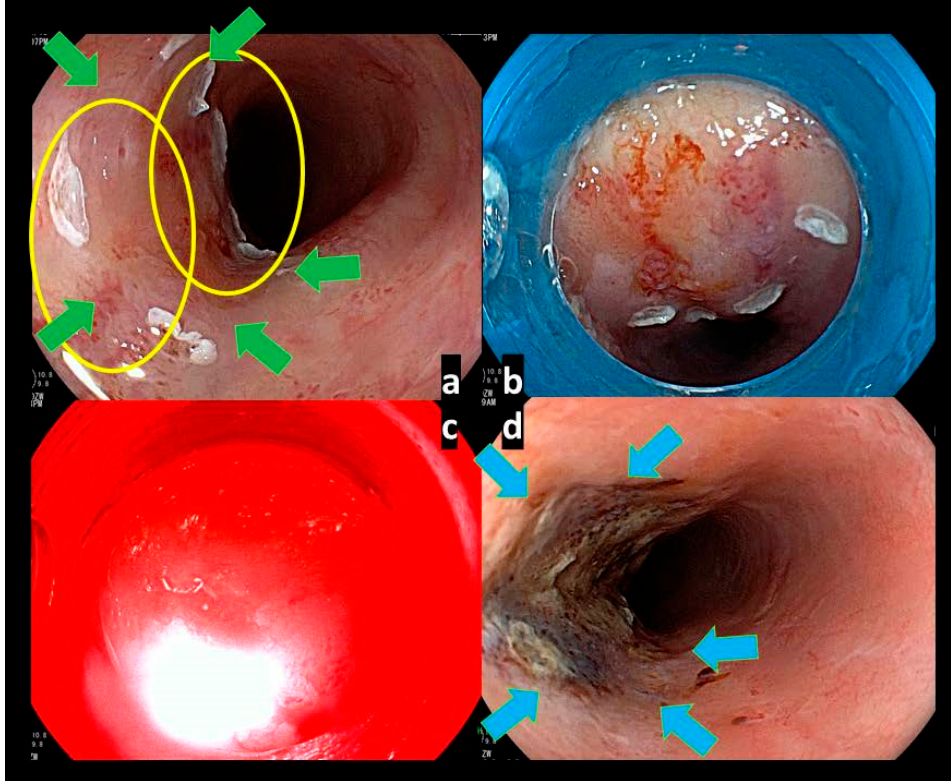
Figure 4. Endoscopic images of PDT procedure for local failure lesion after chemoradiotherapy for esophageal cancer. ( a ) The local failure lesion; we planned to illuminate laser the for two spots (yellow circles) to cover whole the lesion (identified with green arrows). ( b ) An opaque hood was attached at the tip of the endoscope to shield the surrounding mucosa during the illumination in order to avoid esophageal stricture. ( c ) The fluence of the diode laser at 100 J/cm 2 with a fluence rate of 150 mW/cm 2 was delivered through endoscopy, keeping a distance of less than 2 cm from the surface of the mucosa. ( d ) Endoscopic image a day after PDT showing the ischemic change at the laser-illuminated mucosa (identified with blue arrows).